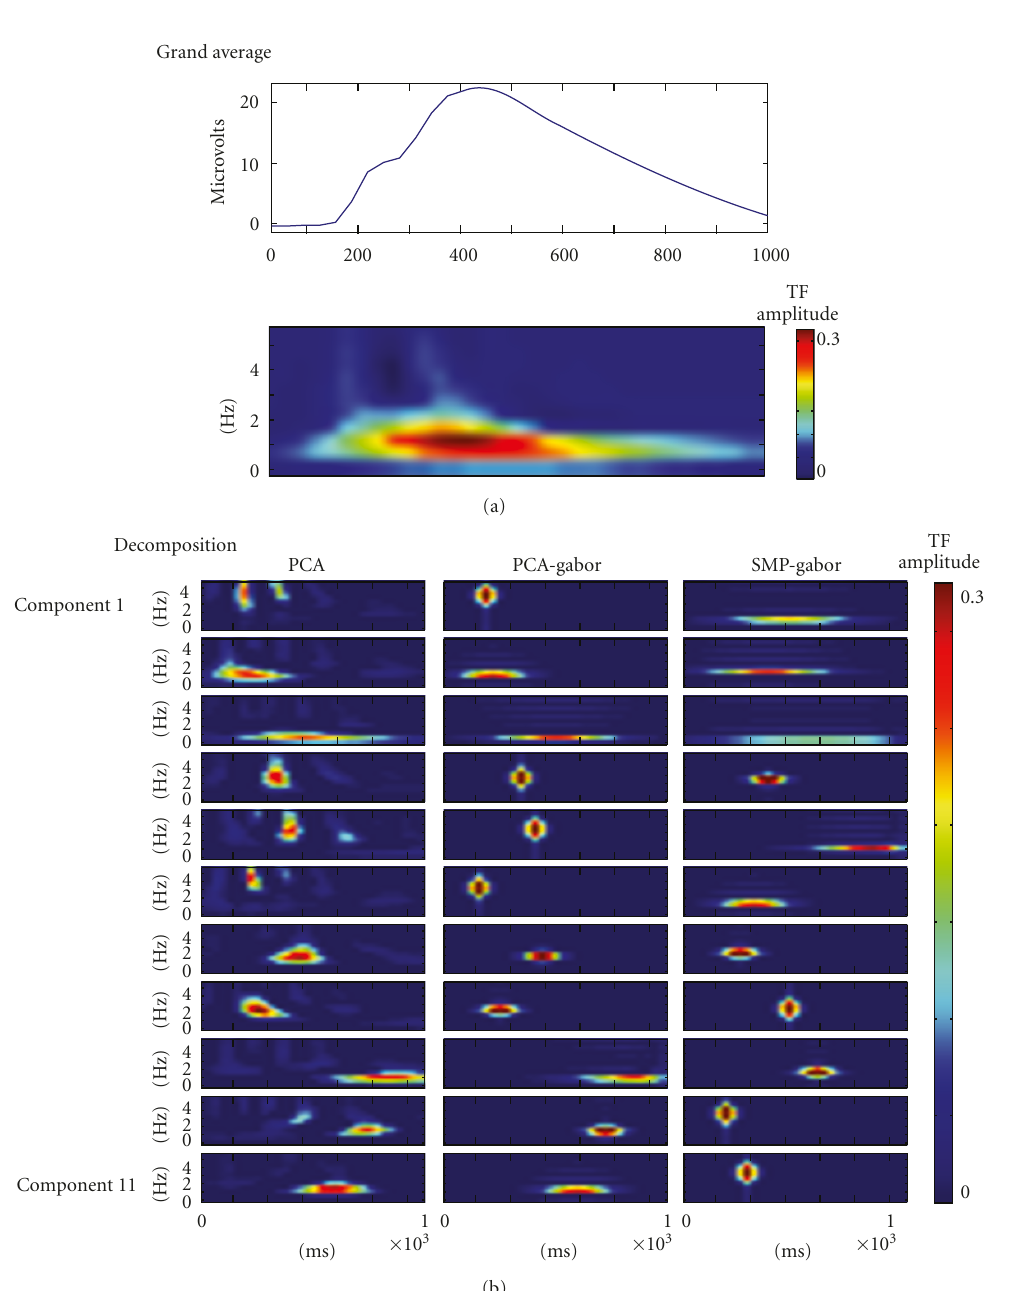
Figure 2: A comparison of the principal components analysis (PCA), Gabor logons extracted from the principal components (PCA-Gabor), and Gabor logons extracted by Simultaneous Matching Pursuit using a Gabor dictionary (SMP-Gabor) for the ERP